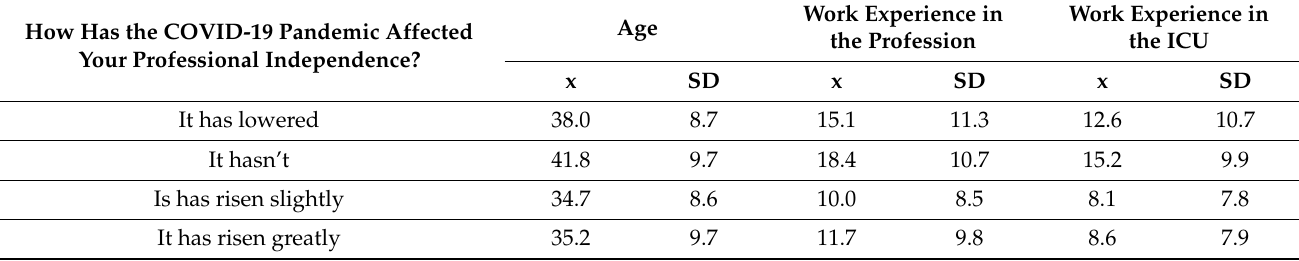
Table 5. The impact of the COVID-19 pandemic on the level of professional independence in particular age and work experience